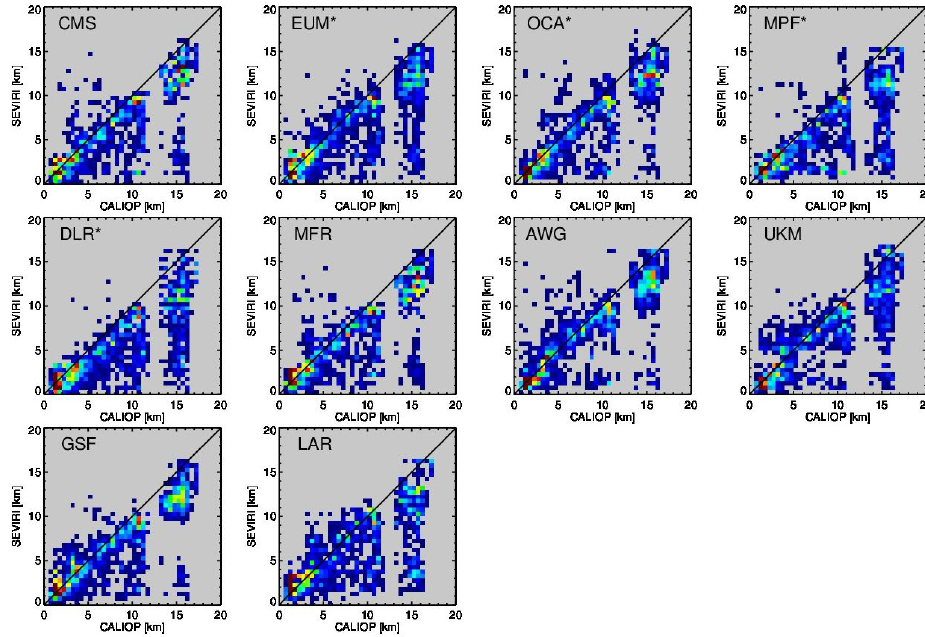
Figure 7. Scatter plots of the cloud top height SEVIRI data sets against the CALIOP data set for 13 June 2008, 12:00–15:30UTC (A- train overpasses 11317–11319). Most of the points are on the lower right side showing that the SEVIRI algorithms derive lower CTH than CALIOP.